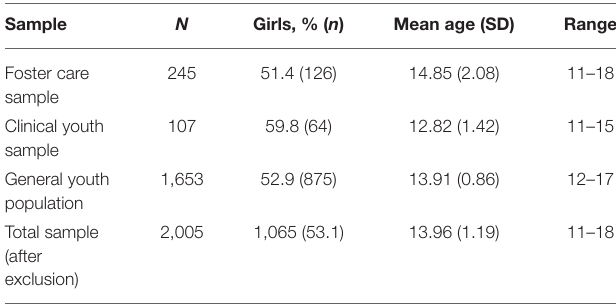
TABLE 1 | Descriptive statistics for the foster care, clinical, and general population youth